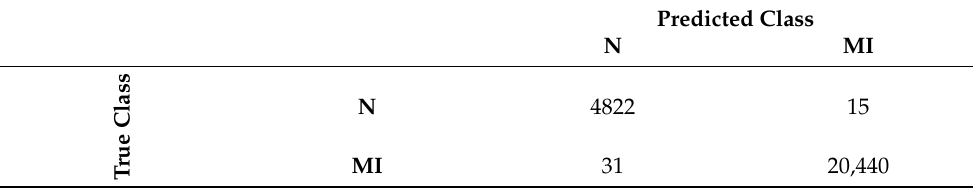
Table 3. Confusion matrix for normal and MI classes in Setting 1.